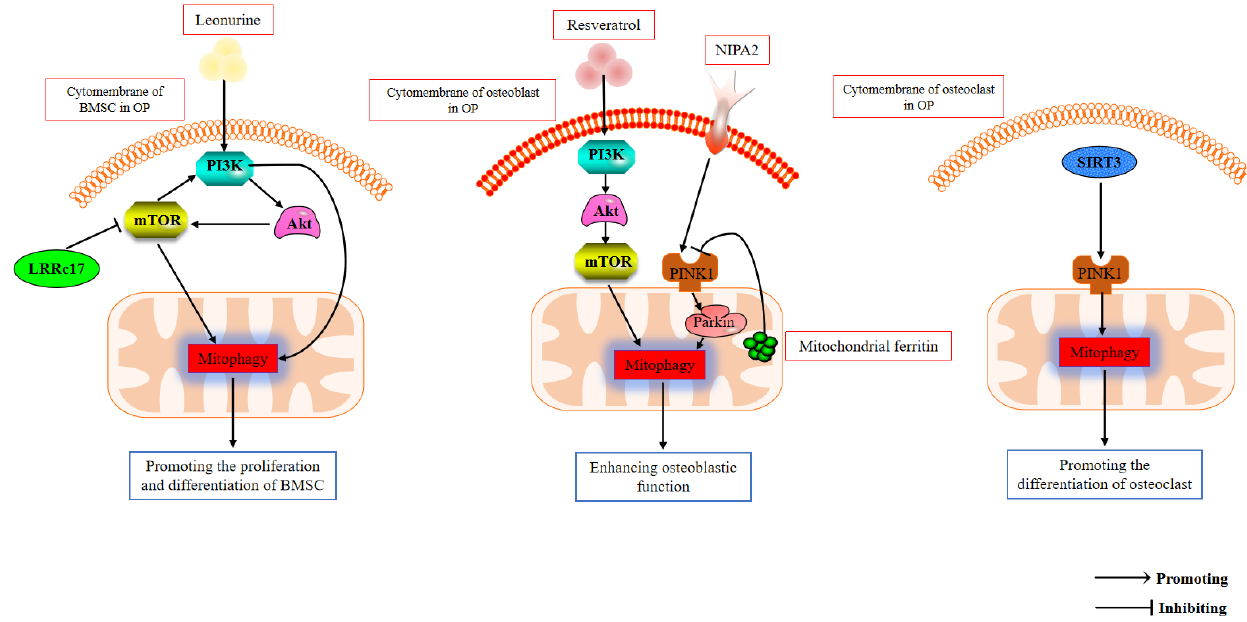
Figure 2. The mechanism of mitophagy in osteoporosis. 5.1. PI3K Signaling Mediates the Regulation of Mitophagy in Osteoporosis